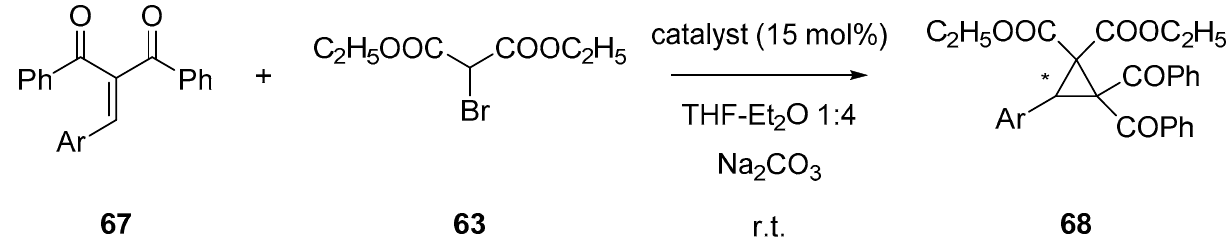
Scheme 15. Michael-initiated ring closure reaction of arylidene-1,3-diphenylpropane-1,3-diones ( 67 ) and diethyl bromomalonate ( 63 ). Table 8. Effect of crown ethers in the MIRC reaction of arylidene-1,3-diphenylpropane-1,3-diones ( 67 ) and diethyl bromomalonate ( 63 ).